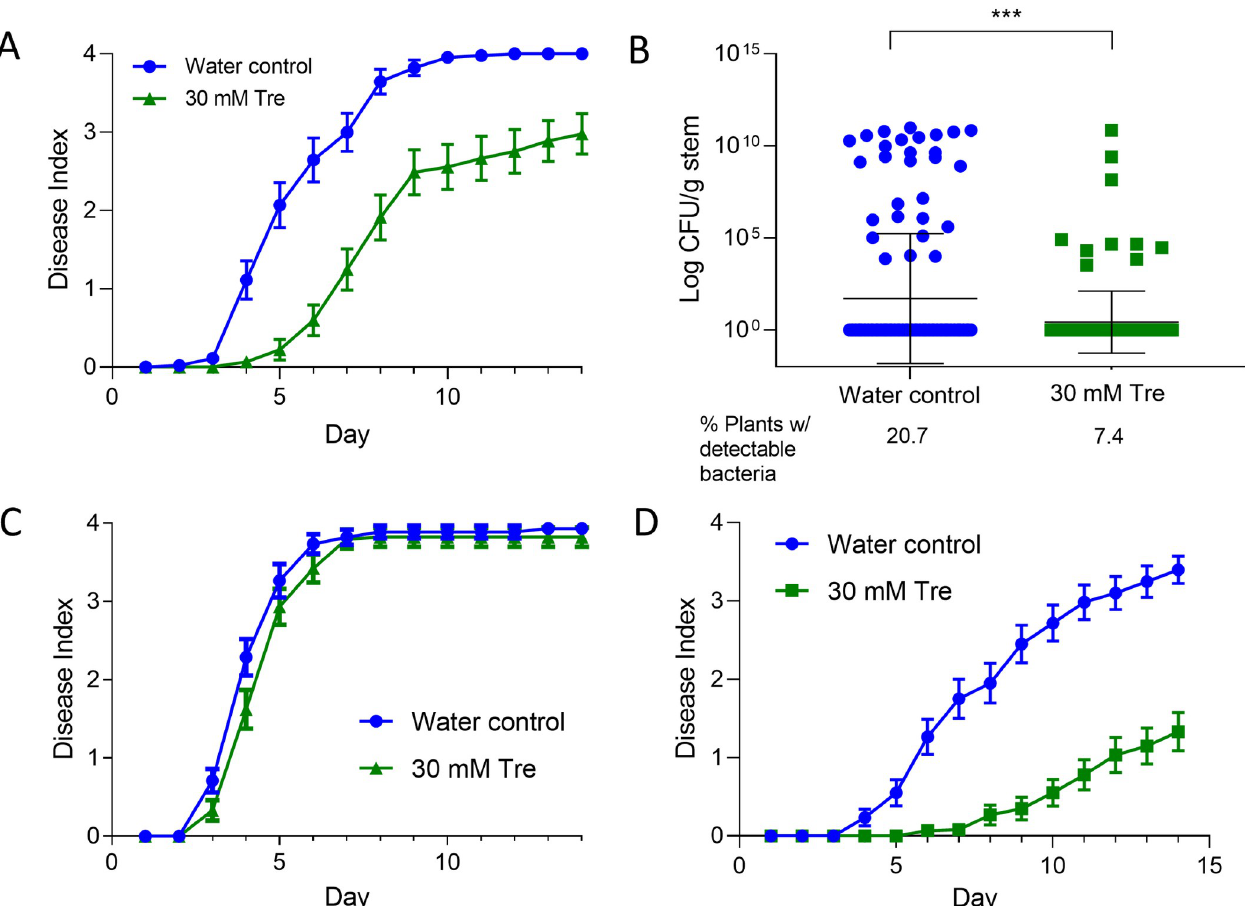
Fig 4. Treating plants with trehalose at the root delayed bacterial wilt symptoms and reduced R . solanacearum stem colonization, but only following soil inoculation. A) Wilt disease progress of cv. Bonny Best tomato plants treated with trehalose, then after 48 h soil soak inoculated with R . solanacearum GMI1000. Disease symptoms were rated on a 0–4 disease index scale where 0 = no wilt, and 4 = 76–100% wilted or dead. Trehalose treatment delayed appearance of wilt symptoms ( P = .0082, t-test comparing areas under the curves or AUC). Data represent three replicate experiments, each with 15 plants/ treatment. Bars represent standard error. B) Bacterial population sizes were smaller in stems of trehalose-treated plants at 5–7 days after inoculation (Mann- Whitney, P = .0009). Data represent three biological replicates with 15 plants/day sampled/treatment; each dot represents the R . solanacearum population size in one plant (including plants without detectable R . solanacearum ). Black bars represent geometric mean and standard deviation of the data. The percentage of plants that contained any detectable R . solanacearum cells is shown below the X-axis; the limit of detection is ~10 2 cells. Relative to controls, fewer trehalose- treated plants contained detectable R . solanacearum populations (Chi-square, P = .0016). C) Disease progress of plants treated with trehalose (green) or water (blue), then 48 h later inoculated by introducing R . solanacearum directly into the xylem through a cut leaf petiole. Trehalose treatment did not affect wilt disease development in petiole-inoculated plants ( P = .2067, T-test of AUC). Data represent three replicate experiments, each containing 15 plants/treatment. Bars represent standard error. D) Disease progress of plants treated with 30 mM trehalose or water, then 120 h later inoculated with R . solanacearum the soil drench method ( P = .0003, T-test of AUC) Data represent four replicate experiments, each containing 15 plants/treatment. Bars represent standard error of the mean.